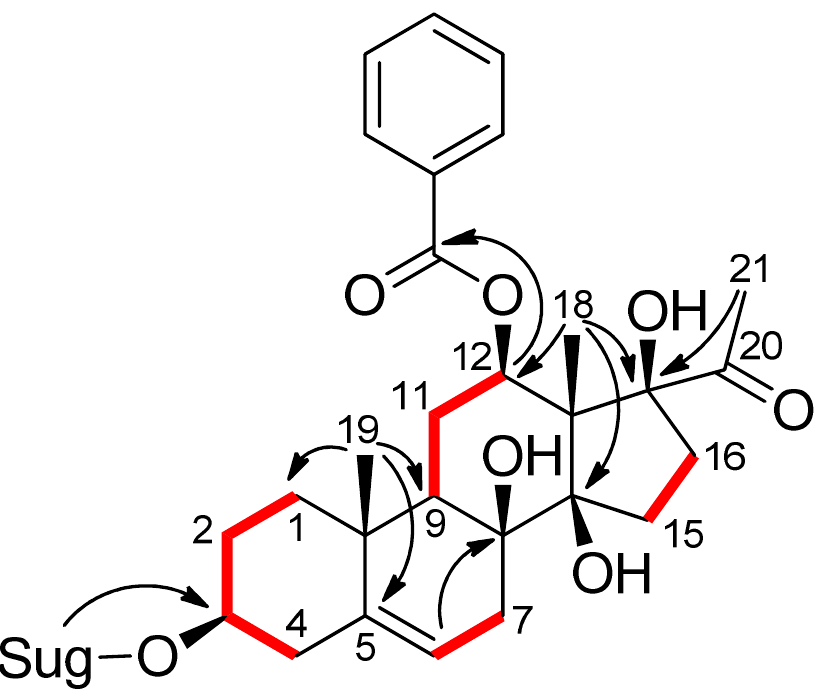
Figure 2. The 1 H- 1 H COSY ( — ) and key HMBC ( → ) correlations of 1 . The aglycone of 1 was supposed to have the same configuration as those of pregnanes isolated from Gymnema sylvestre [10]. The multiplicity of H-12 ( δ H 4.83 (dd, J = 4.2, 11.9 Hz)) implied that the configuration of H-12 was axial ( α -configuration, Figure 2). The NOESY correlations between H-3 ( δ H 3.57), H α -1 ( δ H 1.89), and H α -4 ( δ H 2.40), and between H-12 ( δ H 4.83) and H-9 ( δ H 1.59) determined the configurations of the oxygenated groups at C-3 and C-12 to be β . NOESY correlations detected between H β -1 ( δ H 1.13) and H β -4 ( δ H 2.29) showed the α -position of these protons. The C-12 benzoyl group was confirmed by HMBC correlation from H-12 ( δ H 4.83) to the benzoyl carbonyl C-1 (cid:48) ( δ C 165.5). The large coupling constants between the H-1 and H-2 of monosaccharide moieties, and the HMBC correlations between Thv H-1 ( δ H 4.30) and Cym II C-4 ( δ C 82.8), Cym II H-1 ( δ H 4.76) and Cym I C-4 ( δ C 82.7), and between Cym I H-1 ( δ H 4.85) and aglycone C-3 ( δ C 78.0) indicated the sugar linkages as β - D -thevetopyranosyl-(1 → 4)- β - D -cymaropyranosyl-(1 → 4)- β - D -cymaropyranoside and at C-3 of aglycone. Based on the above evidence, the structure of 1 was elucidated as cynanforidine 3- O - β - D -thevetopyranosyl-(1 → 4)- β - D -cymaropyranosyl- (1 → 4)- β - D -cymaropyranoside, a new compound named euphogossypin A. Compound 2 was isolated as a white amorphous powder. Its 1 H and JMOD spec- tra exhibited the characteristic signals of a pregnane aglycone, one benzoyl unit, and three sugar moieties (Table 1). In addition, NMR data of 2 were similar to those of eu- phogossypin A ( 1 ), except for the difference in sugar units at C-3. A careful analysis of NMR data led to the conclusion that two cymarose units were replaced by two digitoxose monosaccharides. The HMBC correlations between Thv H-1 ( δ H 4.82) and Dig II C-4 ( δ C 84.1), Dig II H- 1 ( δ H 5.41) and Dig I C-4 ( δ C 83.9), and between Dig I H-1 ( δ H 5.48) and aglycone C-3 ( δ C 78.1) confirmed the sugar linkages to be 3- O - β - D -thevetopyranosyl- (1 → 4)- β - D -digitoxopyranosyl-(1 → 4)- β - D -digitoxopyranoside. Consequently, compound 2 was identified as a new compound, cynanforidine 3- O - β - D -thevetopyranosyl-(1 → 4)- β - D - digitoxopyranosyl-(1 → 4)- β - D -digitoxopyranoside, named euphogossypin